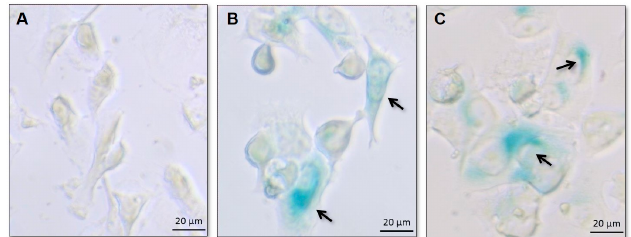
Figure 4. Bright field photomicrographs of MDA-MB-231 cell line of the control group ( A ) or after treatments with PTX ( B ) and DXR ( C ) at a concentration of 70 nM for 48 h. On treated groups, cells are larger and were positively stained for SA- β -gal as indicated by arrows, confirming the occurrence of senescence. Amplification 40×.